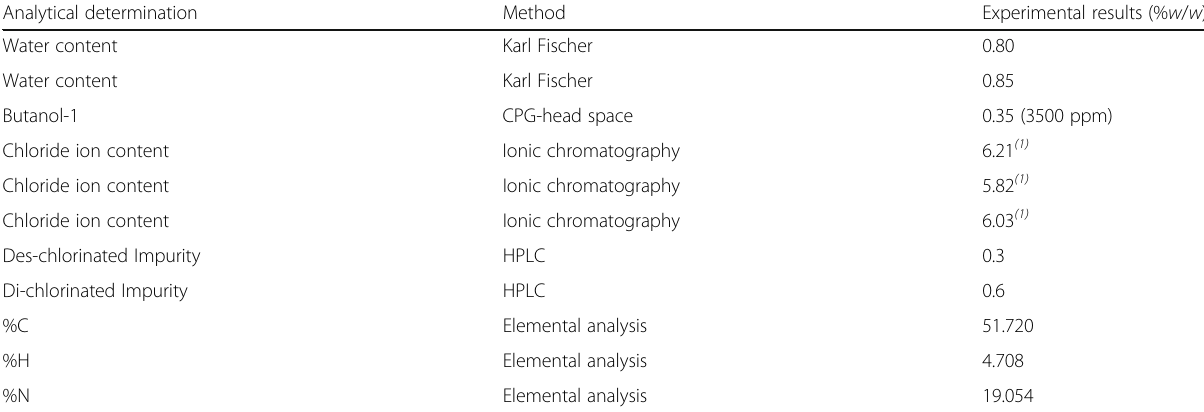
Table 3 Experimental results for the compound C 25 H 25 N 8 O 4 Cl, HCl